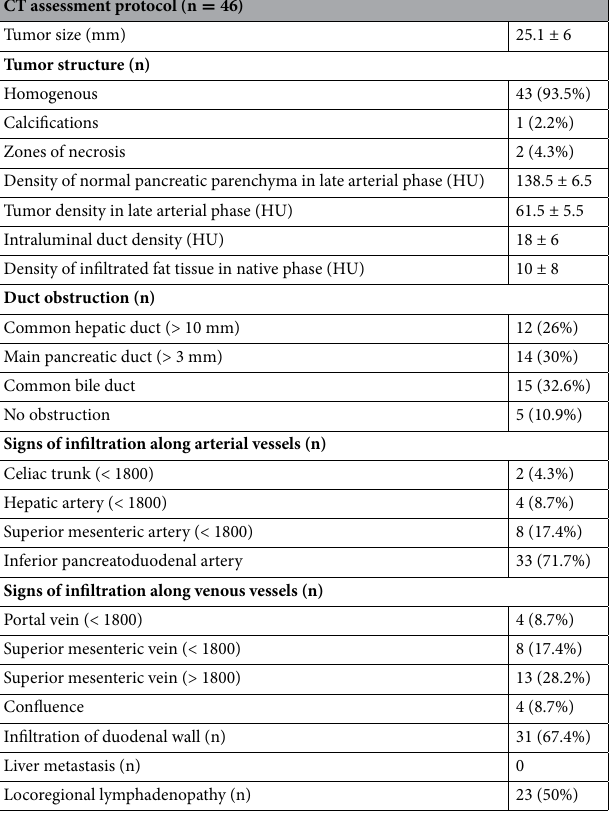
Table 1. Preoperative CT characteristics of 46 patients with adenocarcinoma of pancreatic head (Observer 1).